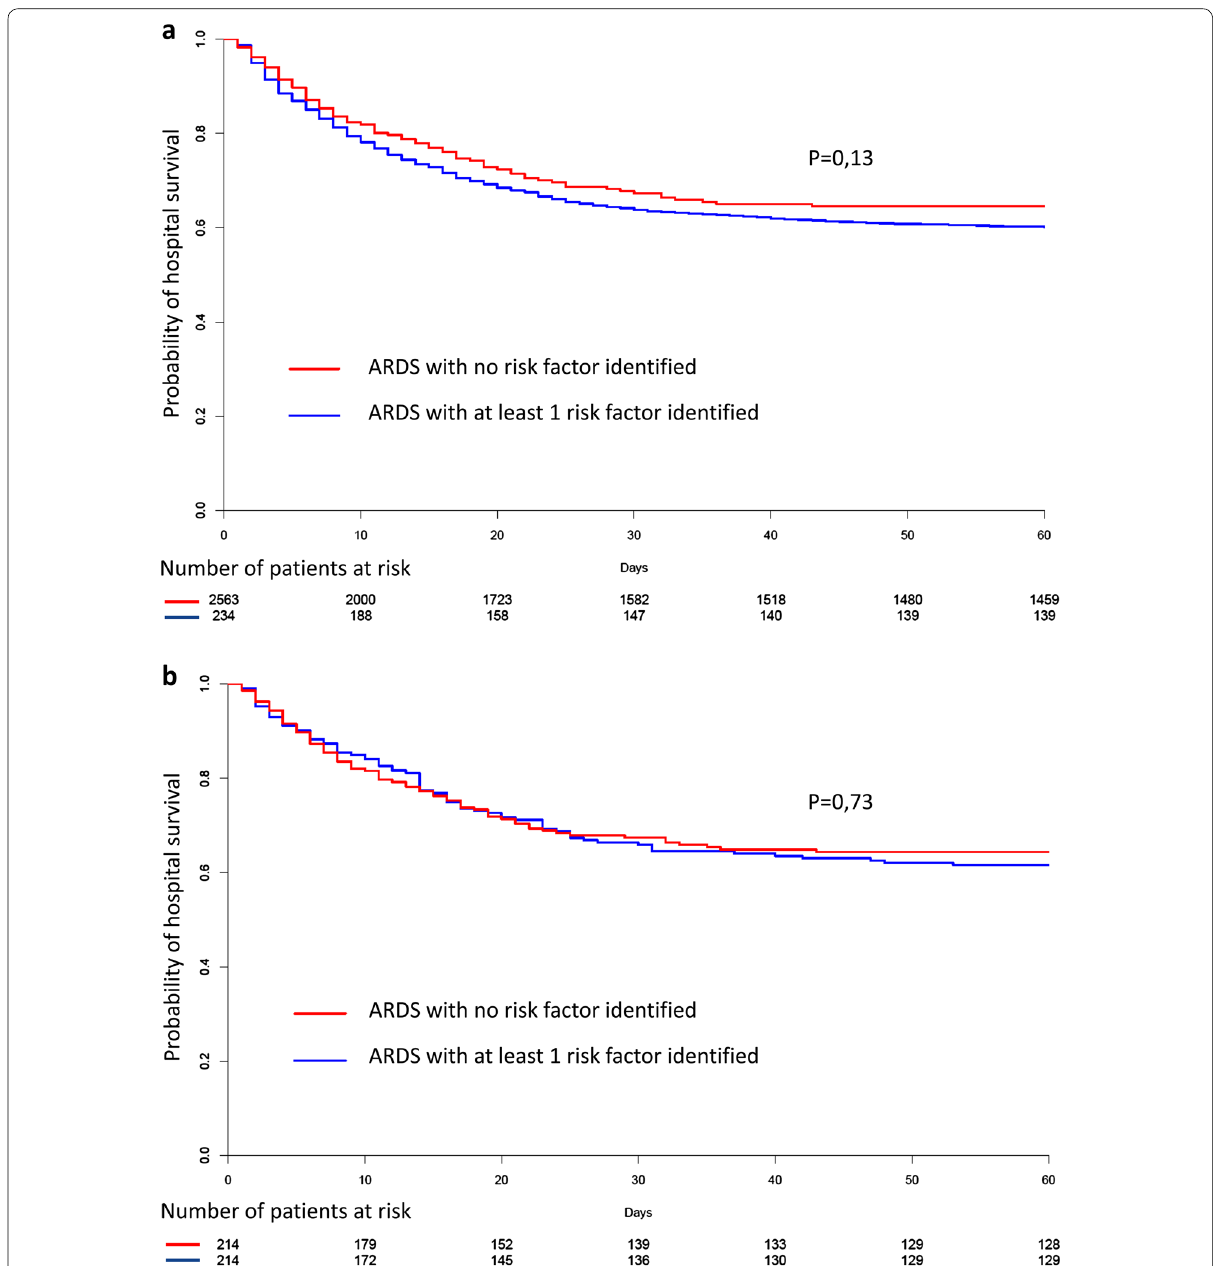
Fig. 3 Kaplan–Meier curves of hospital survival probability in the whole (non‑matched) cohort ( a ) and in the propensity score‑matched cohort ( b ). ARDS patients with no risk factor identified ( red curve ) exhibited a non‑significantly different probability of mortality during hospital stay, as com‑ pared with those having one or more risk factor identified ( blue curve ) both in the whole ( a , p ( b , p 0.73 by the Cox proportional hazard =